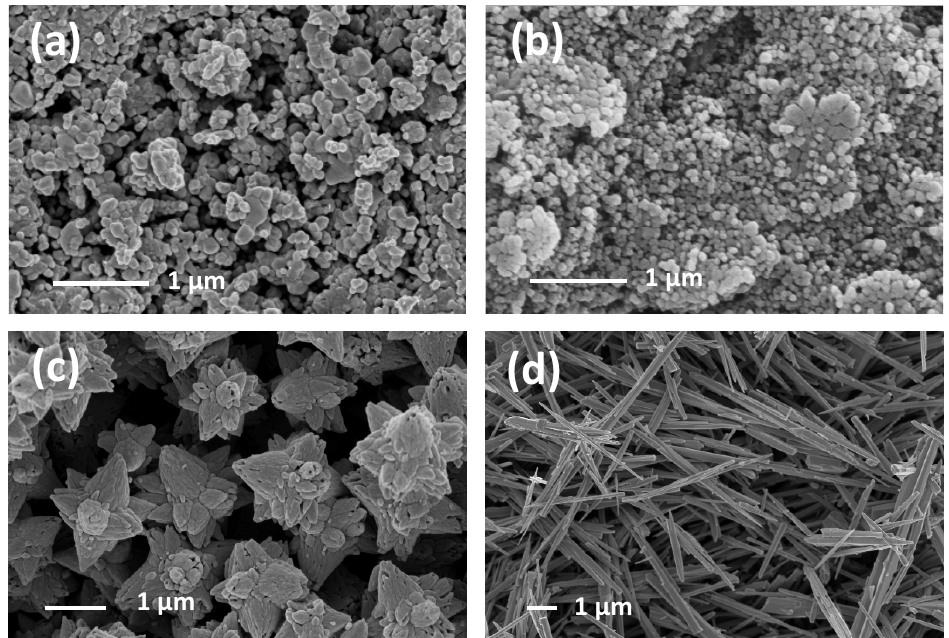
Figure 7. FE–SEM micrographs of the sensing films deposited starting from leaves ( a ), bisphenoids ( b ), stars ( c ), and long needles ( d ).